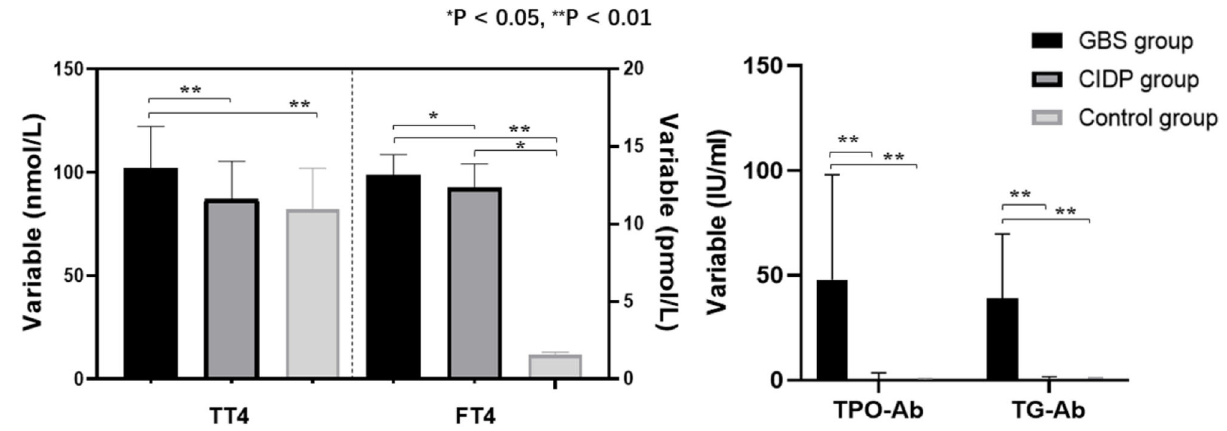
index was obtained. The diagnostic cut-off value of TPO-Ab was 13.7 IU/mL. At this cut-off value, the sensitivity was